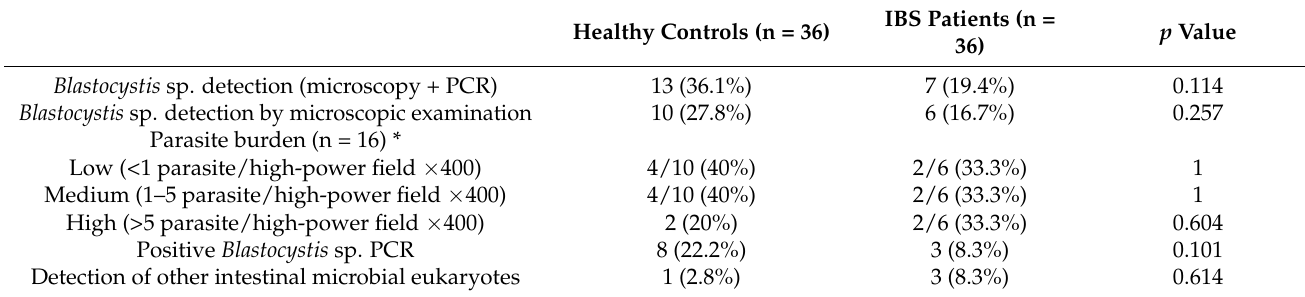
Table 2. Microbiological results among healthy controls and patients with